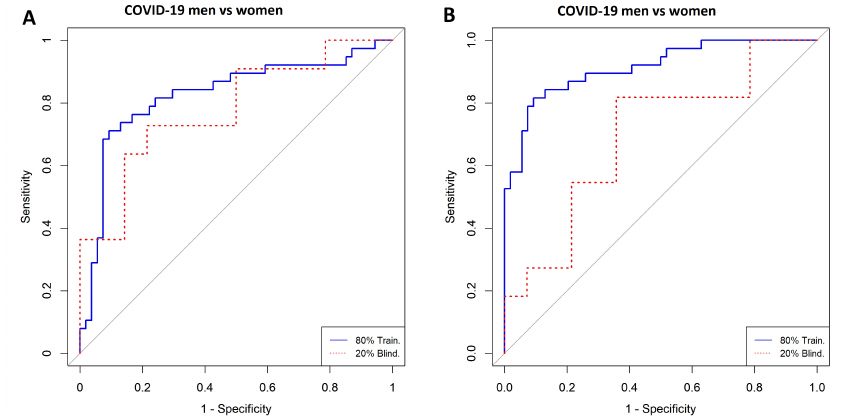
Figure 4. ROC curves for the classification of men vs. women with COVID-19. ( A ) Logistic Regression and ( B ) Support Vector Machine. Model A was built with the following variables: hemoglobin and kynurenine. Model B was built with hemoglobin, kynurenine, and taurine. Table 2. Evaluation of performance for LR and SVM models for male and female COVID-19 patients. Model Men with COVID-19 vs. Women with COVID-19 SVM LR Included